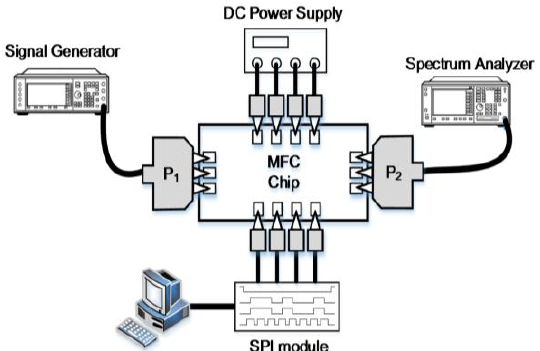
Figure 19. The block diagram of the output power and the gain compression measurement setup as a function of the input power (AM-AM).